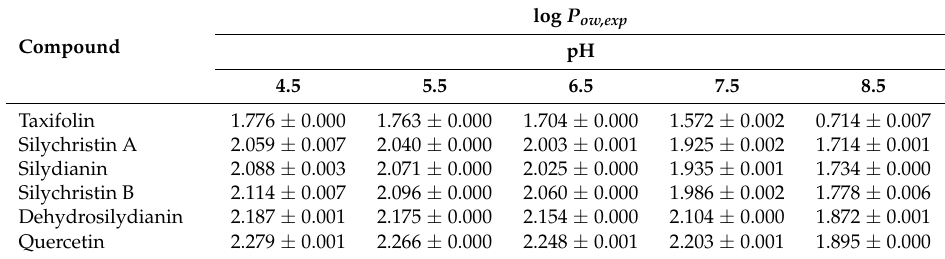
Table A3. Hydrophobicity (log P ow,exp ) of studied compounds in formate buffers.